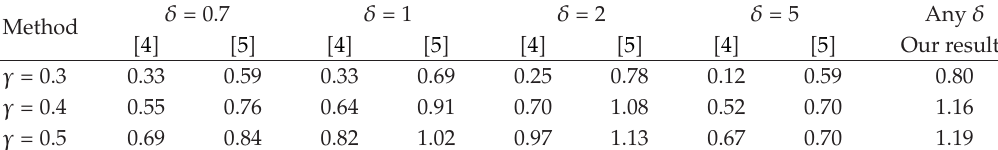
Table 5: Maximum values of h b .